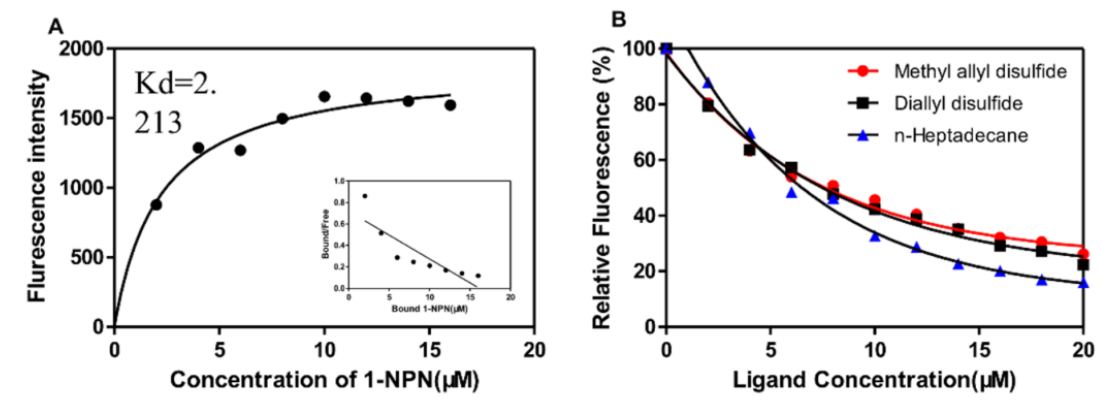
Figure 3. Fluorescence competitive binding assay of BodoOBP8. ( A ) Binding curves for 1-NPN and Scatchard plots; ( B ) Competitive binding curves of two sulfur compounds with BodoOBP8. (Red) methyl allyl disulfide; (black) diallyl disulfide; (blue) n-heptadecane.